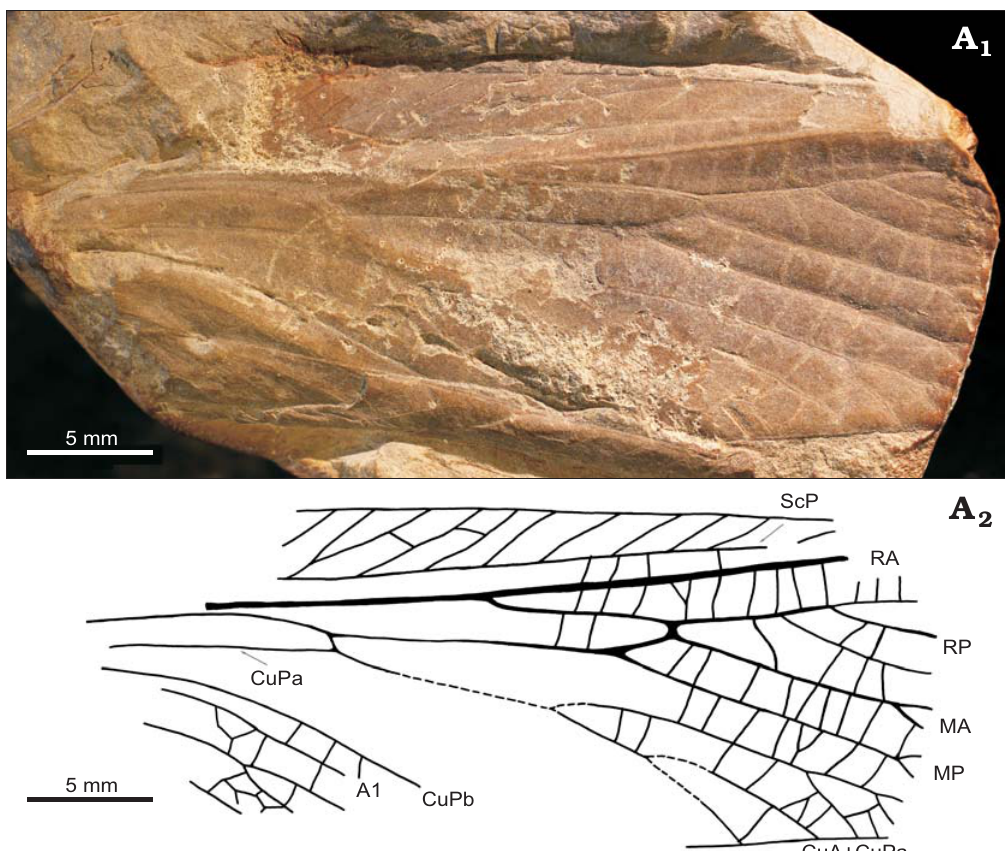
Fig. 4. Forewing venation of archaeorthopteran insect Parapalaeomastax dariuszi gen. et sp. nov., holotype (MP ISEA ISEA I − F/MP/1540/20/09), Carboniferous, Pensylvannian, Langsettian (Westphalian A), Sosnowiec-Klimontów, Upper Silesian Coal Basin, Poland. Photograph (A 1 ) and explana- tory drawing (A 2 ). Abbreviations: A1, first anal vein; CuA, cubital anterior; CuPa/b, anterior/posterior branch of cubital posterior; MA/P, media anterior/ posterior; RA/P, radius anterior/posterior; ScP, subcosta